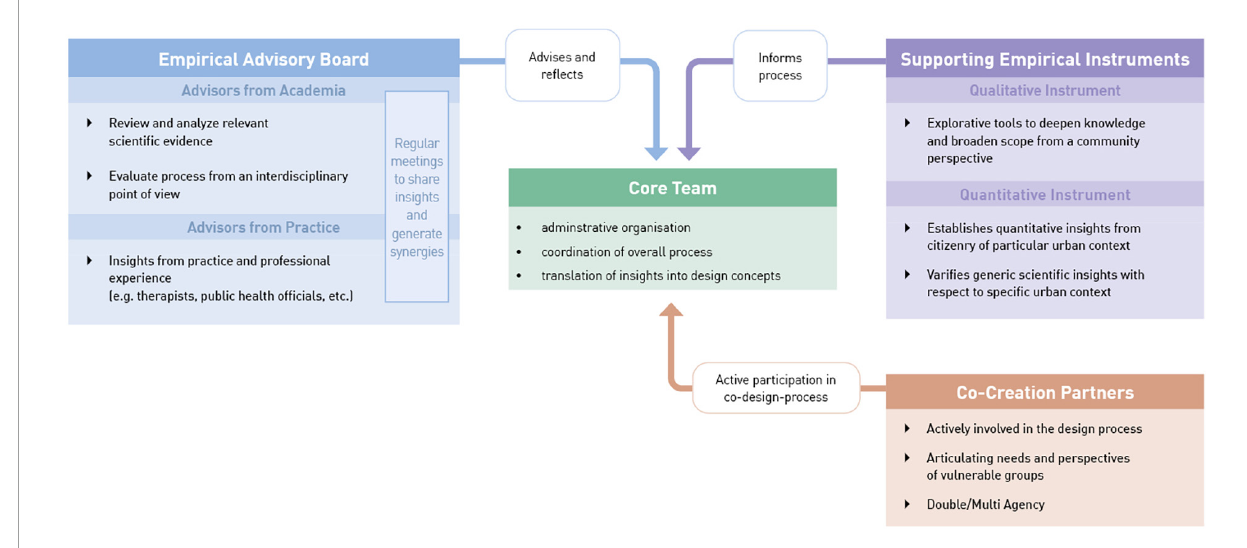
FIGURE3 Structural model of the research and design